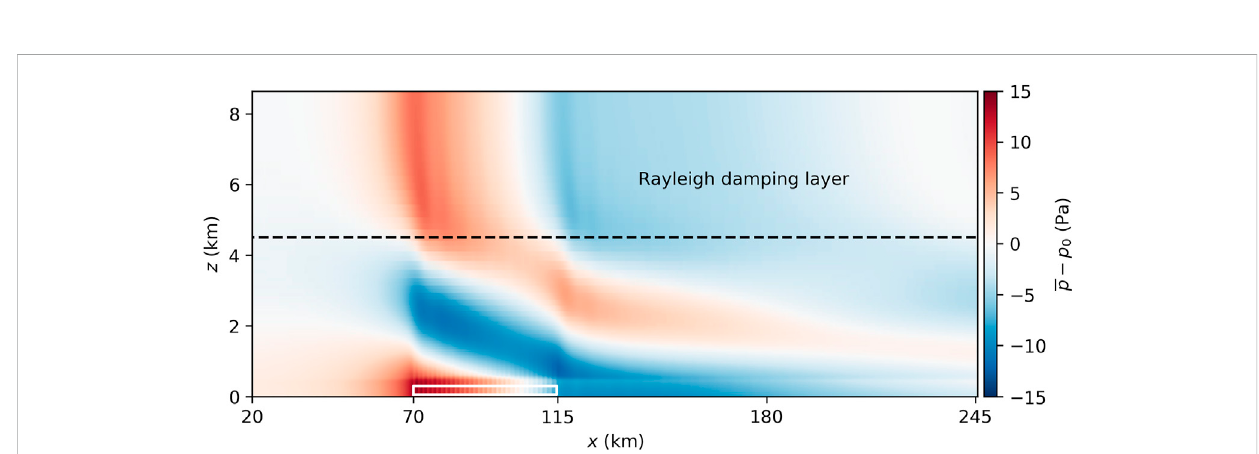
FIGURE 5 Meanperturbationpressureinaverticalcrosssectionthroughthecenterofthewindfarm.Thepressureisgivenasdeviationfromthepressureatthe in fl ow at the same height ( p 0